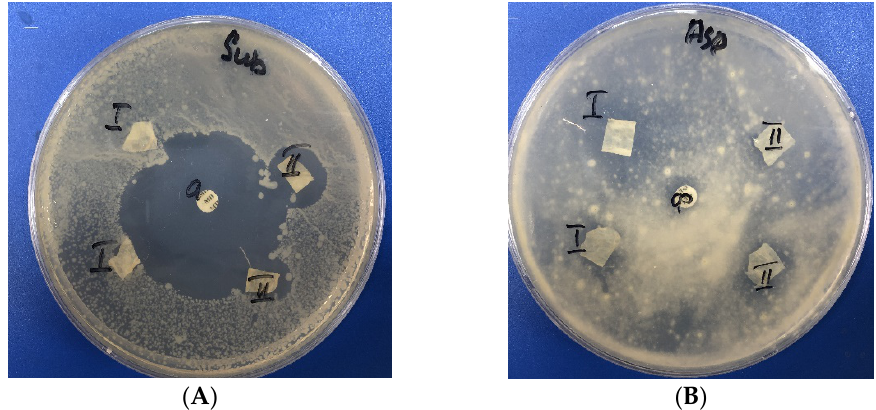
Figure 8. Antimicrobial activity of bacterial cellulose films with Ag and plasma treatment